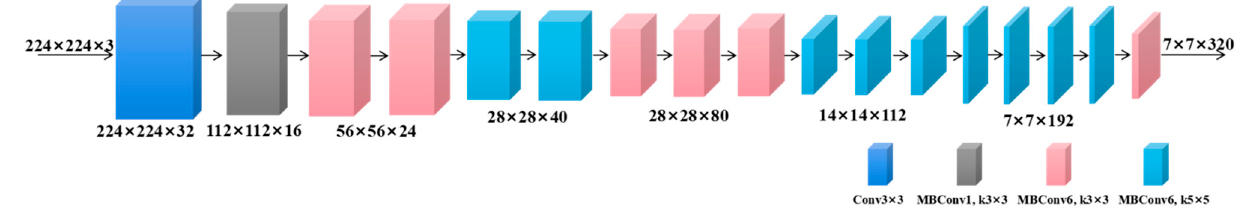
Figure 7. Baseline network for EfficientNet-B0.